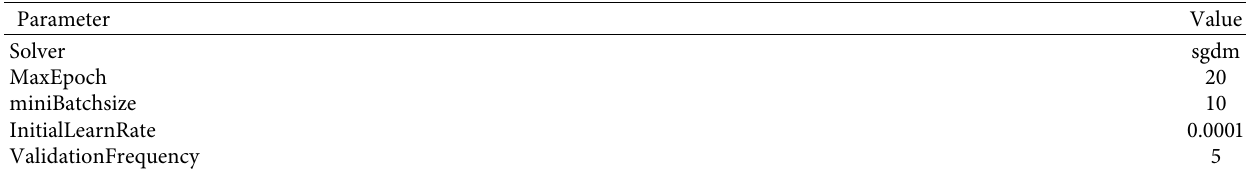
Table 2: Parameter